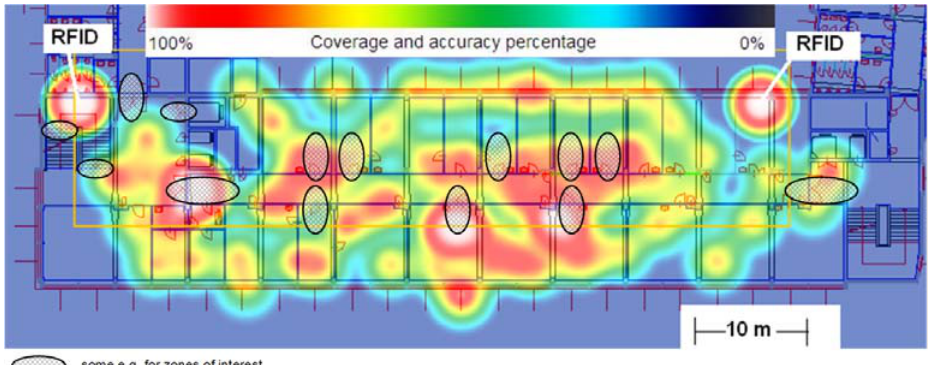
Figure 2. RSS distribution of observed APs and zones of interest for iCPs (after Retscher, 2007)